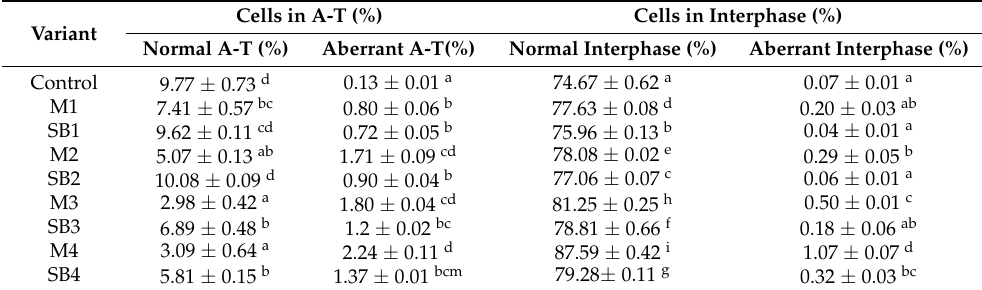
Table 2. Frequency of genetic abnormalities in mitotic cycle of Triticum aestivum root meristem cells treated with Merlot and Sauvignon blanc grape marc